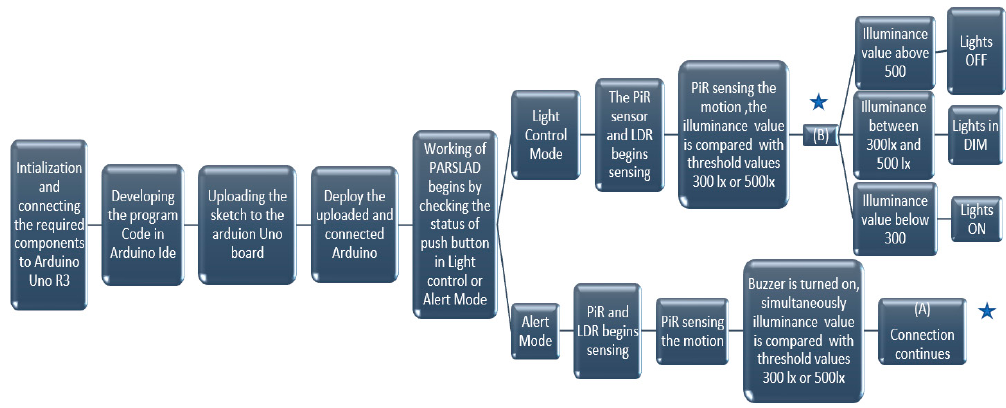
Figure 3. PARSLAD